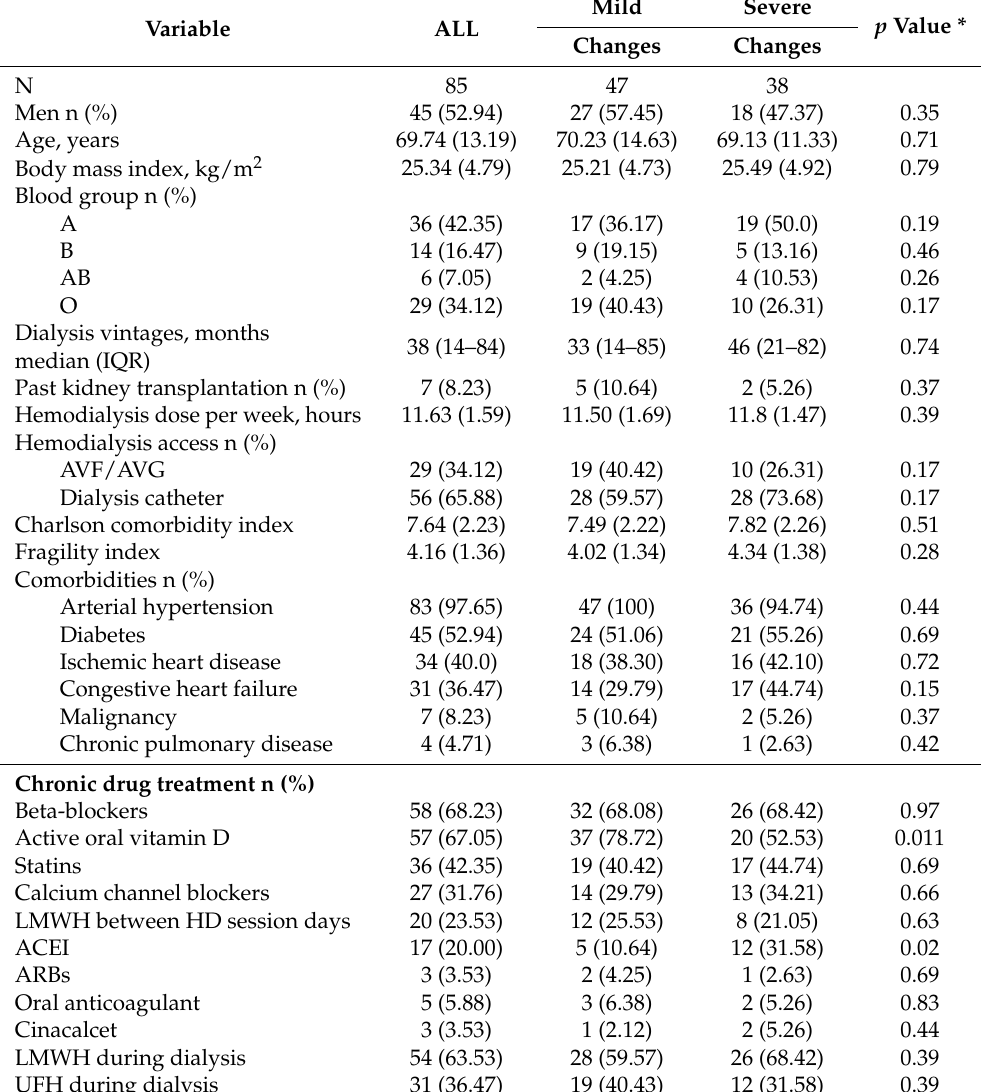
Table 1. Characteristics of cases stratified according to the extent of inflammatory lesions in the